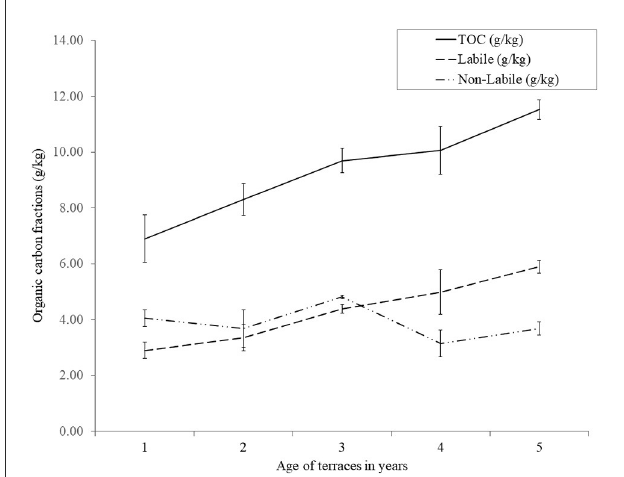
FIGURE5 Effect of age of terraces (Fanya Juu and Fanya Chini) on organic carbon fractions in cropping system of maize-bean intercrop. The line shows means trends of each variable while error bars indicate the standard deviation.